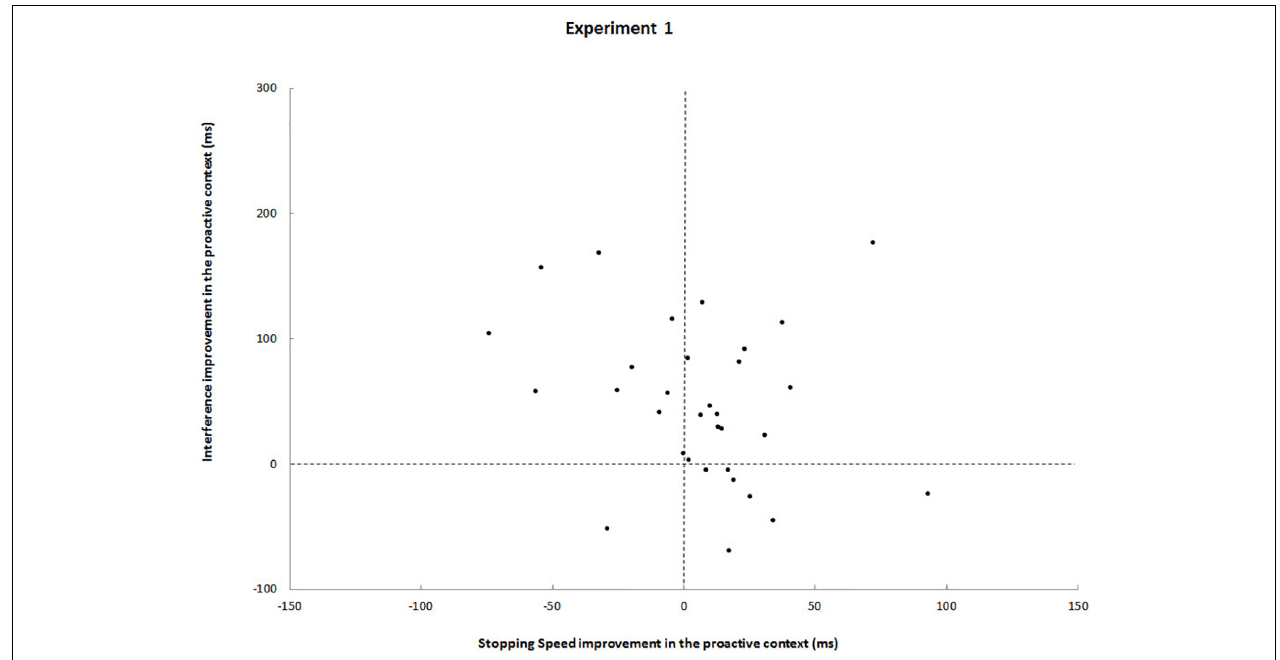
FIGURE 2 | Each black dot represents a participant. Upper left quadrants, participants who improved from foreknowledge in interference but deteriorated in stopping speed; Upper right quadrants, participants who improved from foreknowledge in both interference and stopping speed; Lower left quadrants, participant who deteriorated in both measures; Lower right quadrants, participants who improved from foreknowledge in stopping speed stopping speed but deteriorated in